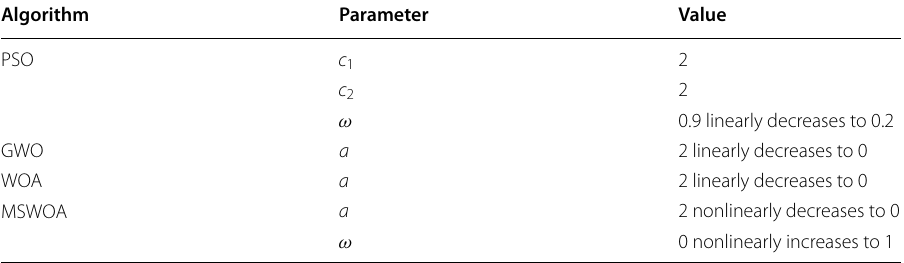
Table 2 Parameter setting